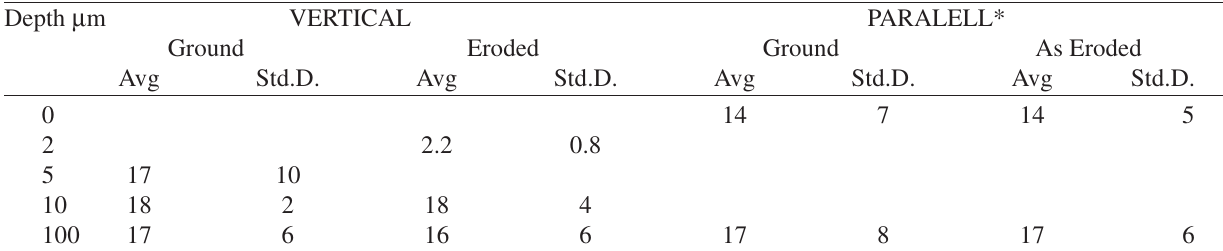
Table 3. Inter-crack distance at different depths in the eroded coating of calcium stabilized zirconia ( µ m). Depth µ m VERTICAL Ground